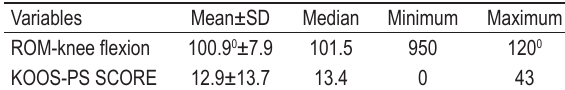
TABLE 2. Mean, standard deviation and median of knee‑ROM and